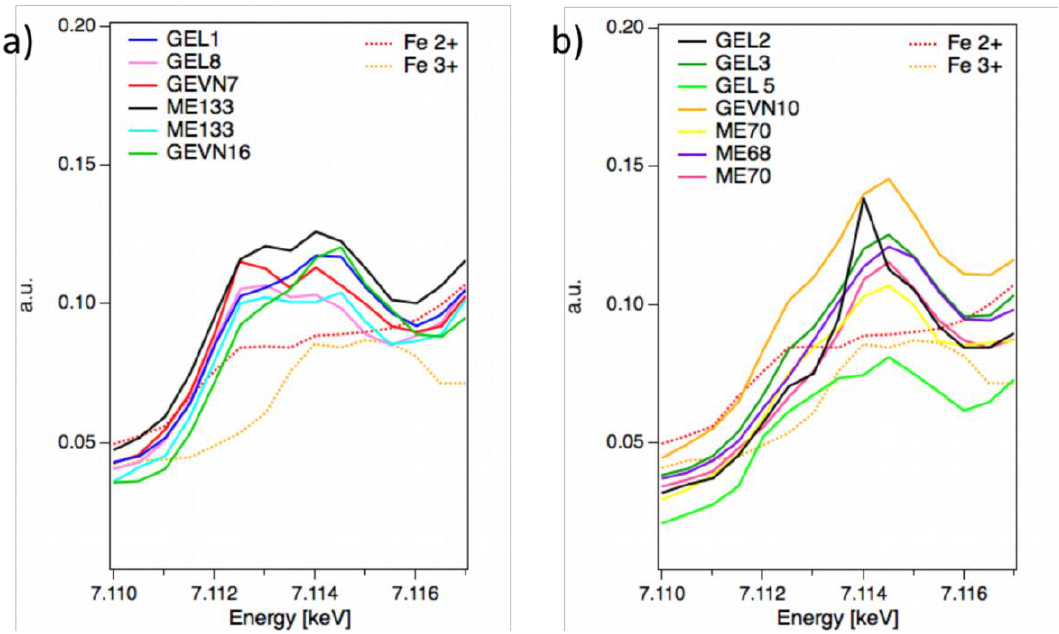
Figure 2. Fe-XANES spectra acquired on a 3 µm × 4.2 µm spot on the gloss layer of the samples indicated in the legend, all mounted in cross section geometry. Samples of panels ( a ) exhibit a mixture of both Fe 2+ and Fe 3+ , while samples on panel ( b ) mainly Fe 3+ .